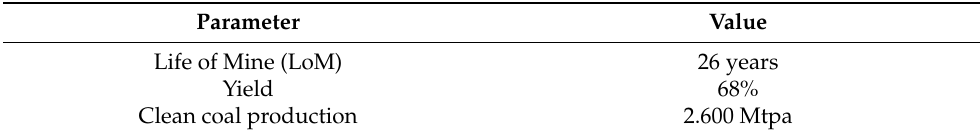
Table 4. Basic assumptions for the economic analysis